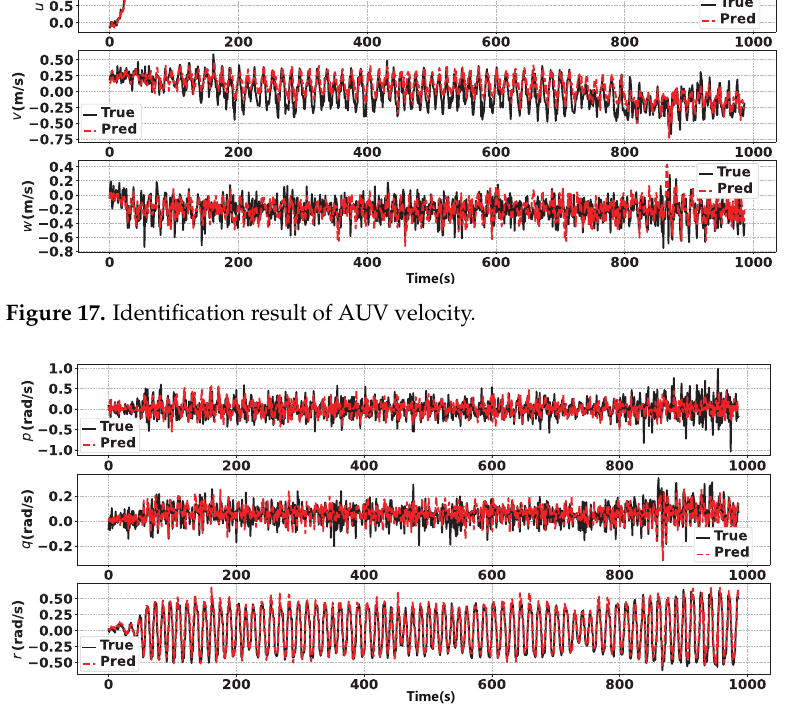
Figure 18. Identification result of AUV angular velocity.